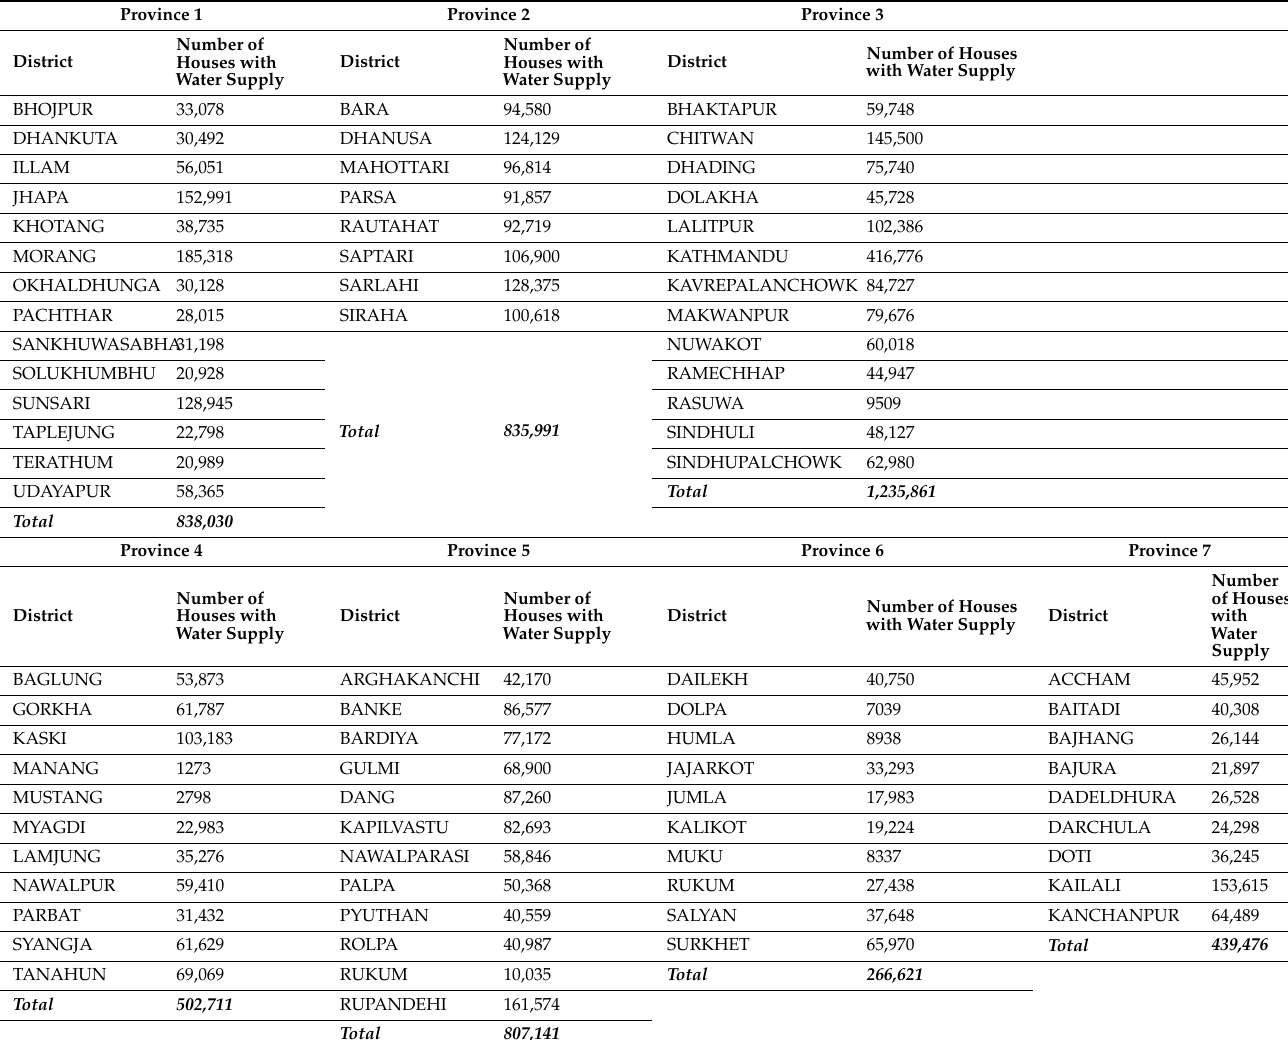
Table 4. Classification of water supplies all over Nepal based on